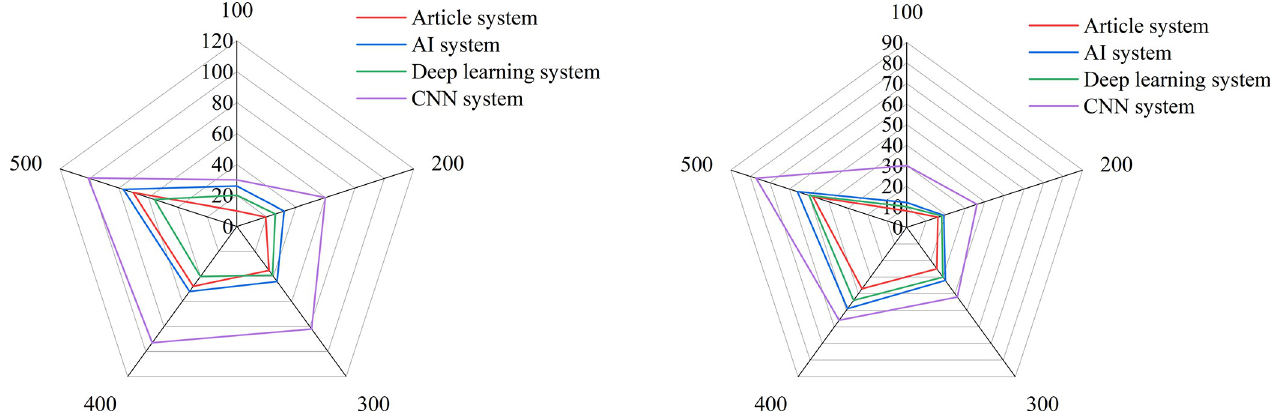
Fig 14. The occupancy of different smart classroom systems.